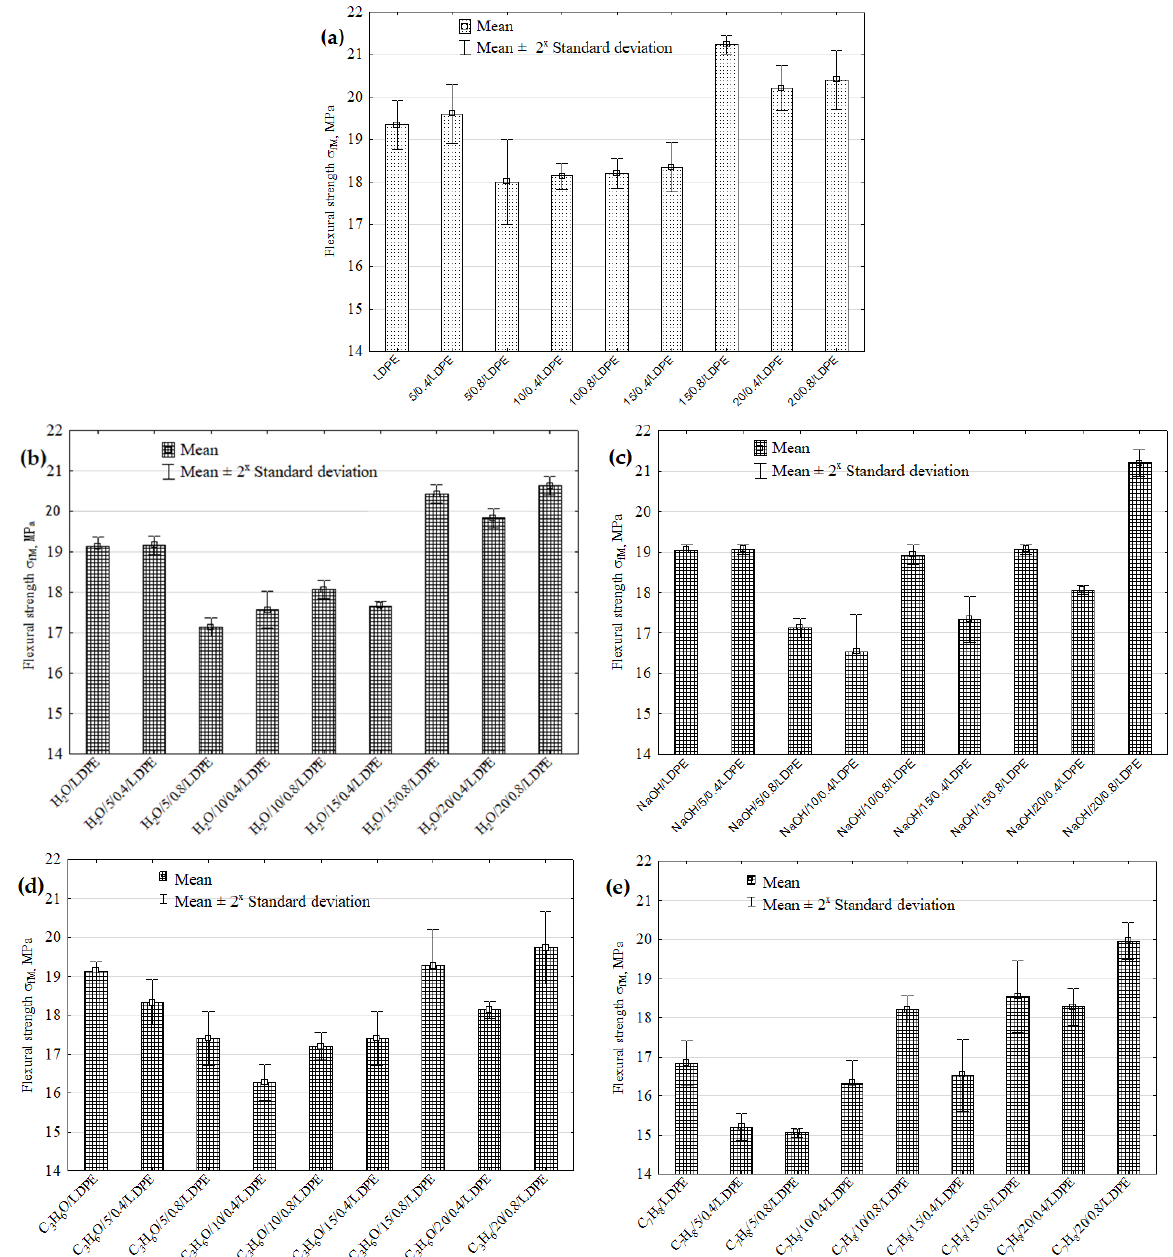
Figure 4. Flexural strength of pure LDPE and LDPE with a natural filler versus different solvents: ( a ) reference samples, ( b ) distilled water, ( c ) NaOH solution, ( d ) acetone, ( e ) toluene.